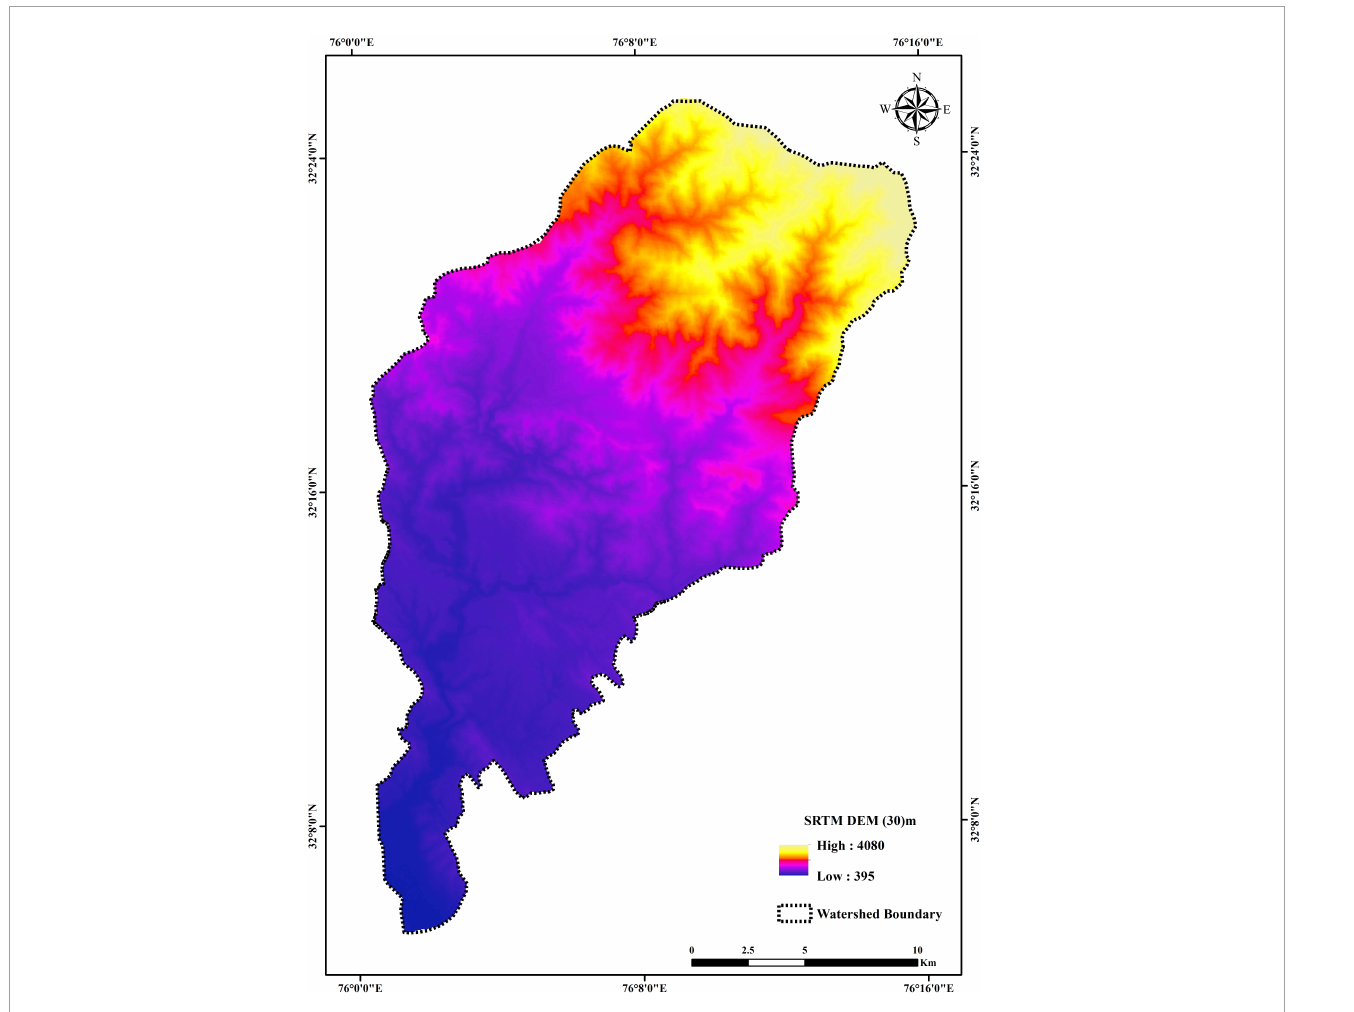
FIGURE5 Digital elevation model (DEM) of the Dehar